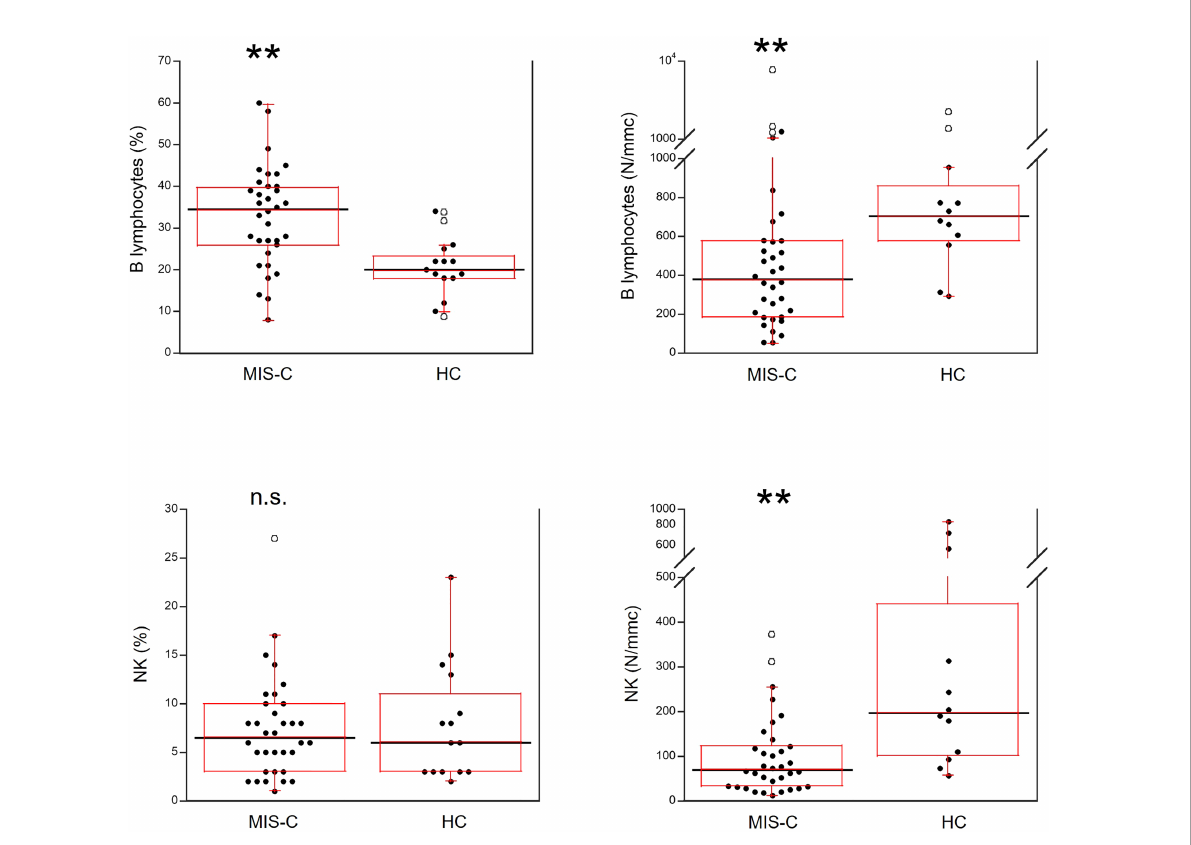
FIGURE 5 Comparison of B and NK lymphocytes in 37 patients with MIS-C and in 24 HC. The black line represents the median value. The red box represents the interquartile range. The blank circles correspond to the outliers and the black circles side by side to these correspond to duplicates **p < 0.001; n.s.: not signi fi cant (p >